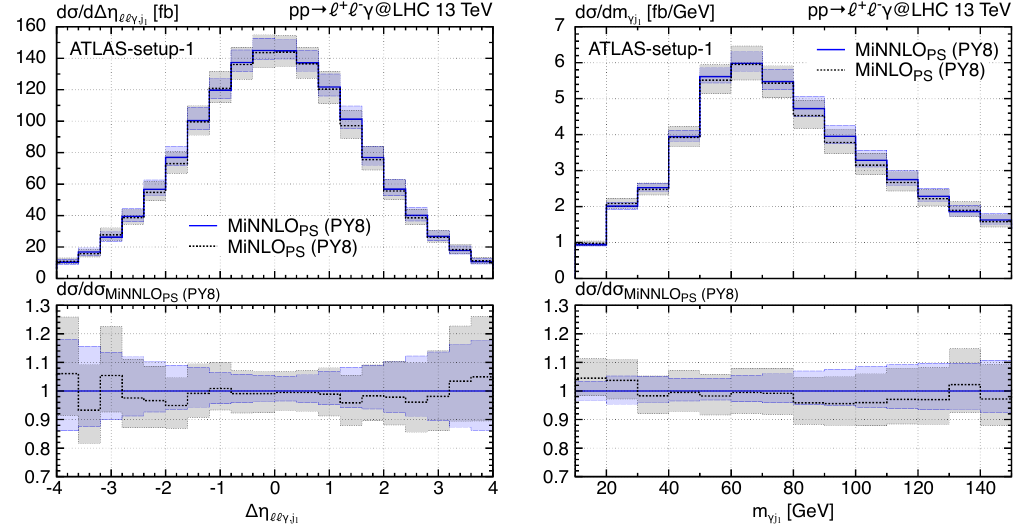
Figure 4. Distribution in the pseudorapidity difference of the colour-singlet and the hardest jet (left plot) and in the invariant mass of the photon and the hardest jet (right plot) for MiNNLO (blue, solid line) and MiNLO 0 (black, dotted line).